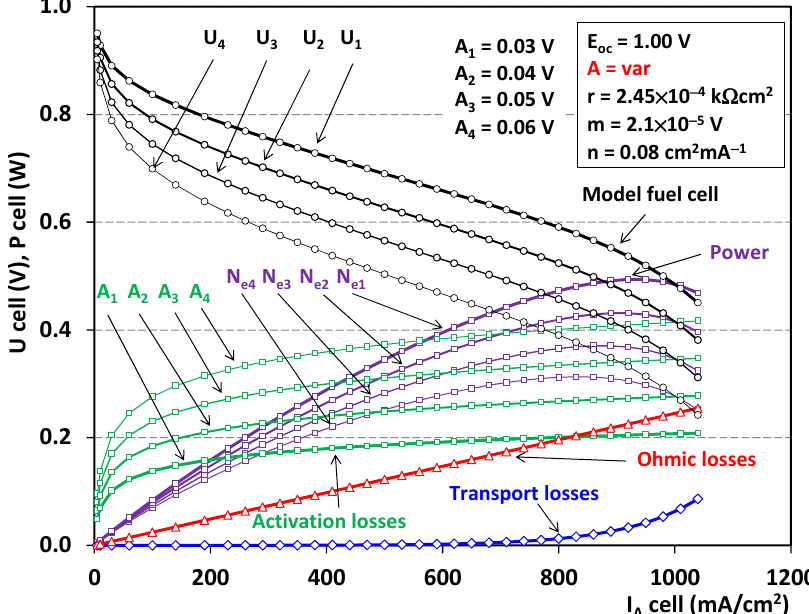
Figure 6. Impact of the changing A parameter of a fuel cell on the I–U characteristics and fuel cell losses.